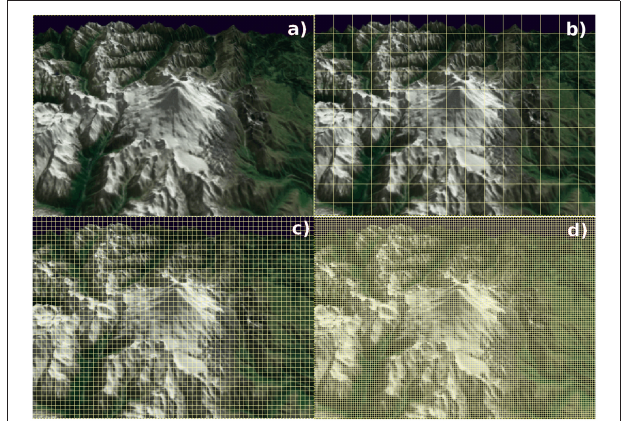
FIGURE 1 | Schematic illustration of grids of different resolutions laid over a Mt. Elbrus map: (A) 15km, (B) 1km, (C) 250m, (D)